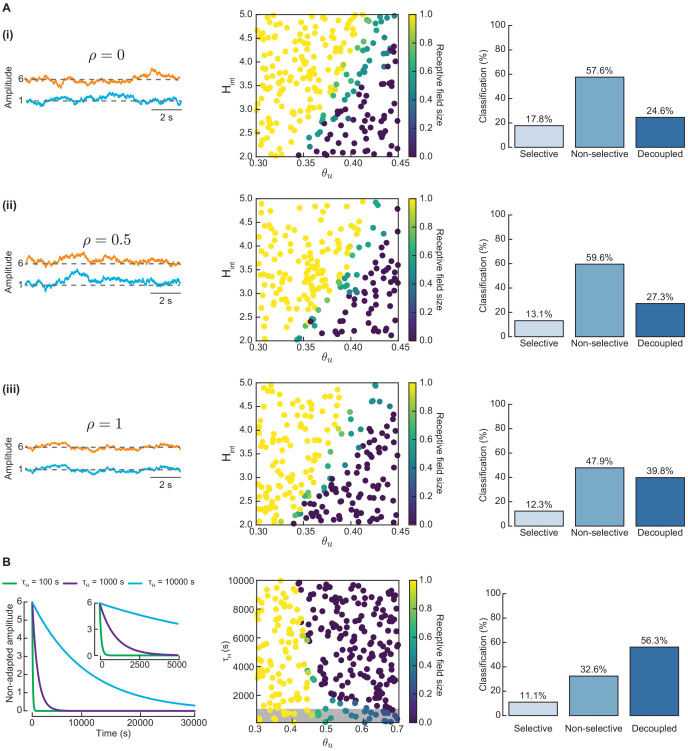
Long-term fluctuations in the amplitudes of L- and H-events cannot guide proper network refinement. (A) Correlated fluctuations in the amplitudes of L- and H-events are not sufficient to guide proper network refinement. Left: Amplitudes of L- (blue) and H-events (orange) follow Ornstein-Uhlenbeck processes of different correlation strengths, ρ: (i) uncorrelated (ρ=0), (ii) intermediate correlation (ρ=0.5), and (iii) perfect correlation (ρ=1). We simulated the model with non-adaptive H-events with these different correlation strengths. Middle: Receptive field sizes for 200 Monte Carlo simulations in the same parameter space of θu and Hint as the manuscript. Right: Simulations were classified into three possible outputs: selective, non-selective, and decoupled networks. (B) A top-down signal which imposes an exponential decay of H-event amplitudes during development (independent of ongoing network activity) enhances receptive field refinement only if the decay is very fast. Left: Exponential decay of non-adaptive H-event amplitudes. We simulated the model with non-adaptive H-events with different amplitude decay time constants τH={100,1000,10000} s. The inset shows a detail of the beginning of the simulation. Middle: Receptive field sizes for 300 Monte Carlo simulations for non-adaptive H-events with exponentially decaying H-event amplitudes in the range τH∈[100,10000] s and input thresholds in the range θu∈[0.3,0.7]. The gray box indicates simulations with very fast decaying amplitudes (τH<1000 s) that generate refined receptive fields. Right: Simulations classified into three possible outputs: selective, non-selective, and decoupled networks.